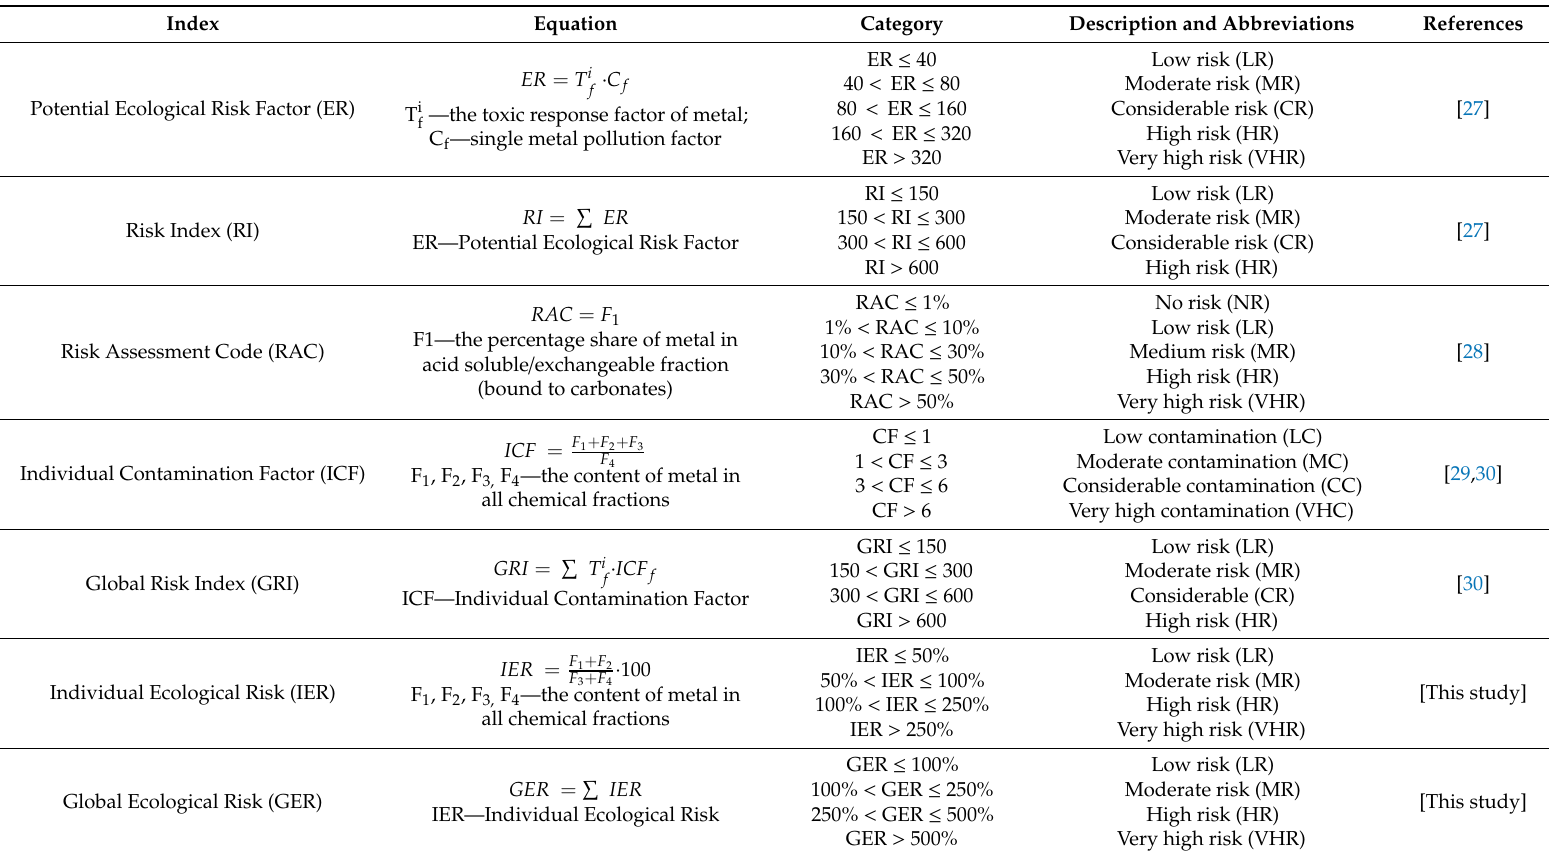
Table 4. Indices for ecological risk